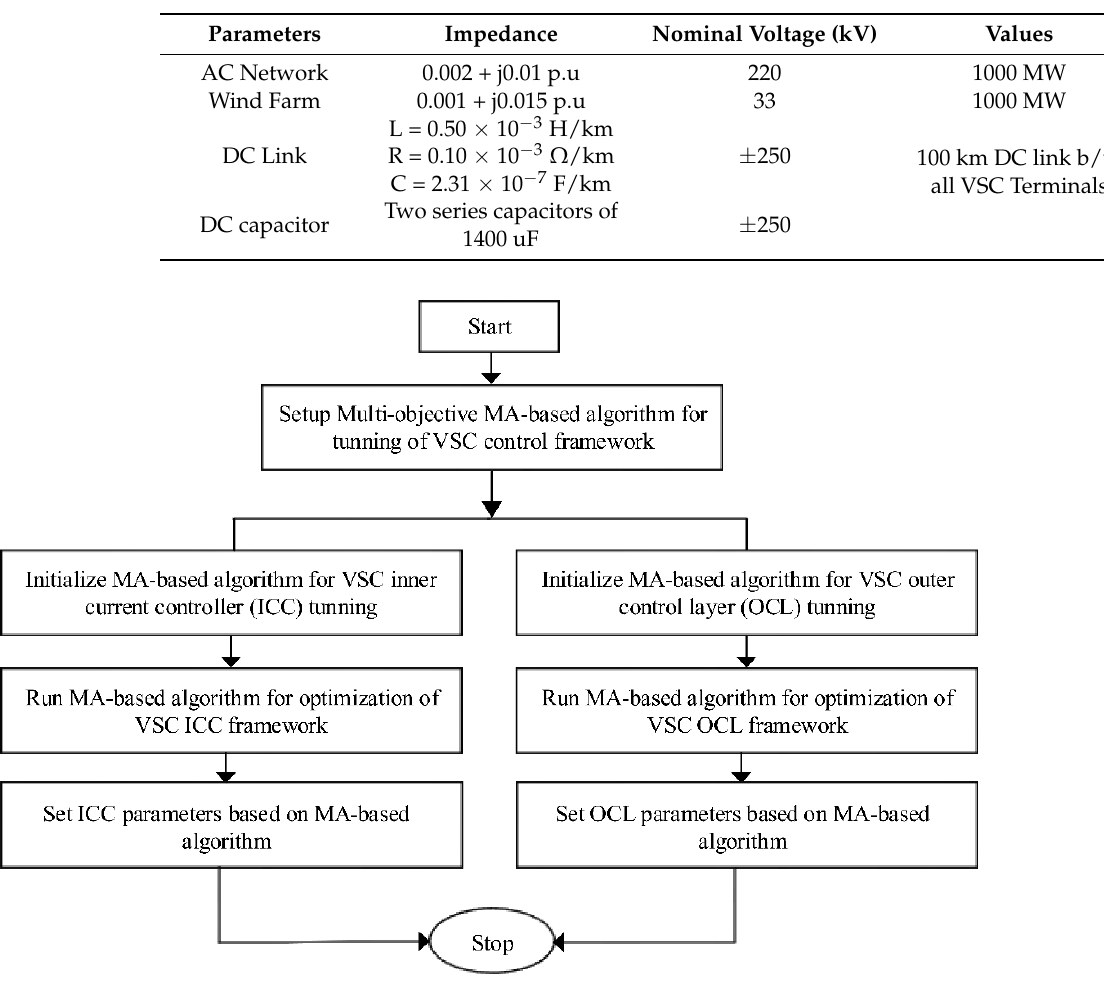
Figure 2. Optimization of the VSC-based control framework using the proposed